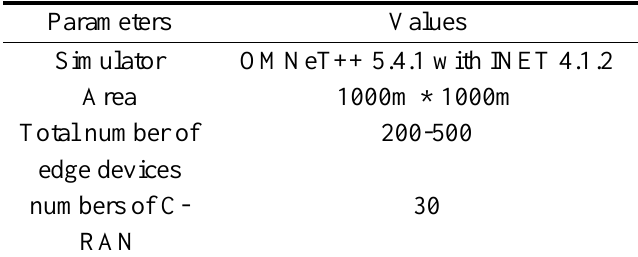
Table 1. Stimulation